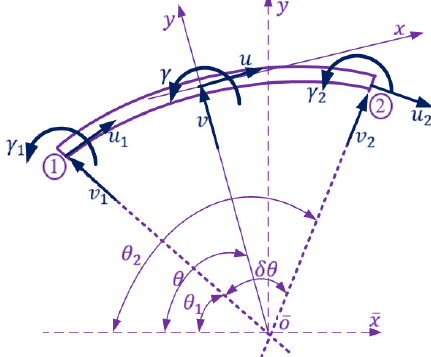
Figure 2. Definition of in-plane displacements for the curved beam element 2.3 The stiffness matrix of the Timoshenko curved beam element